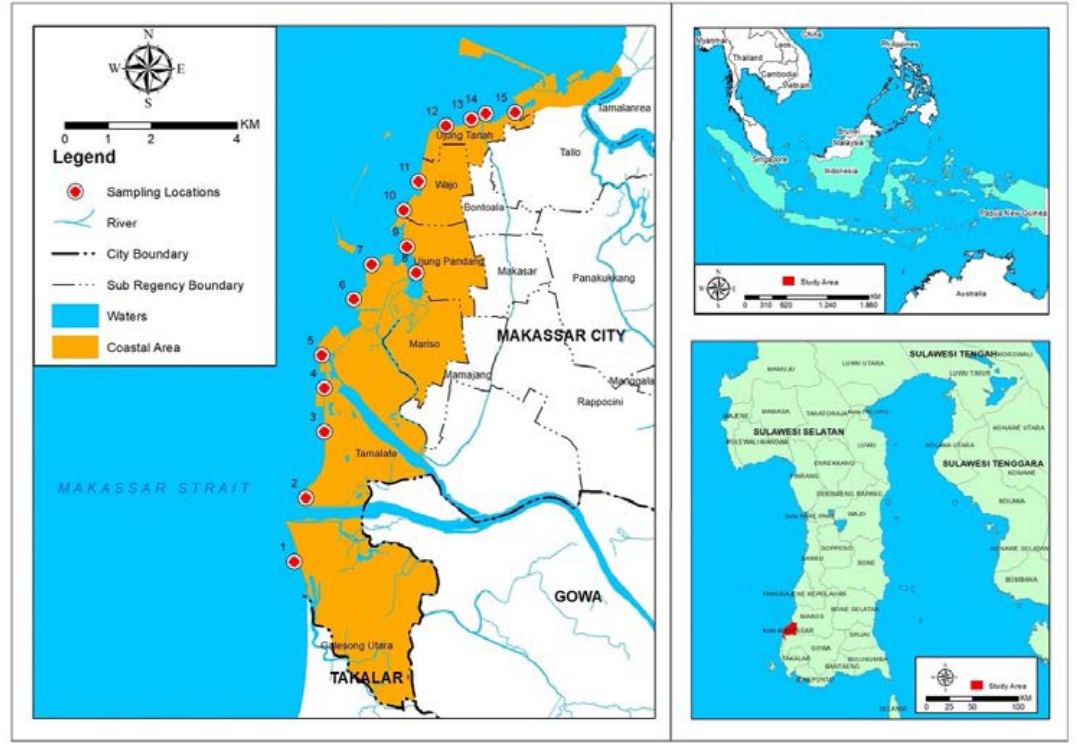
Fig. 1: Geographic location of the study area in estuarine water of Makassar coastal area, South Sulawesi Province,